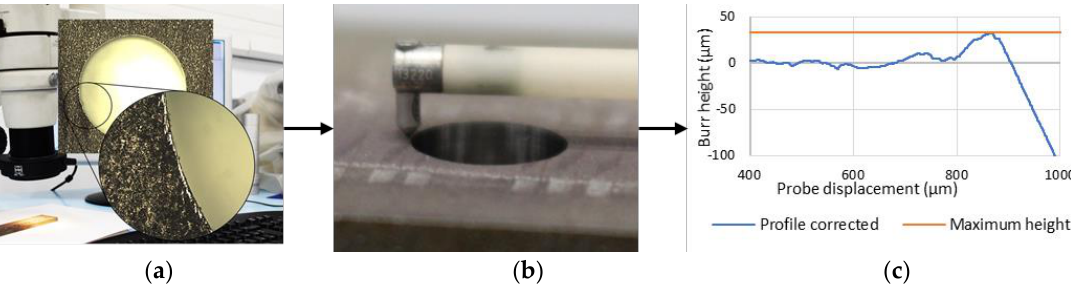
Figure 4. Burr evaluation procedure. ( a ) Visual inspection. ( b ) Obtaining the surface profile. ( c ) Burr weight measurement.